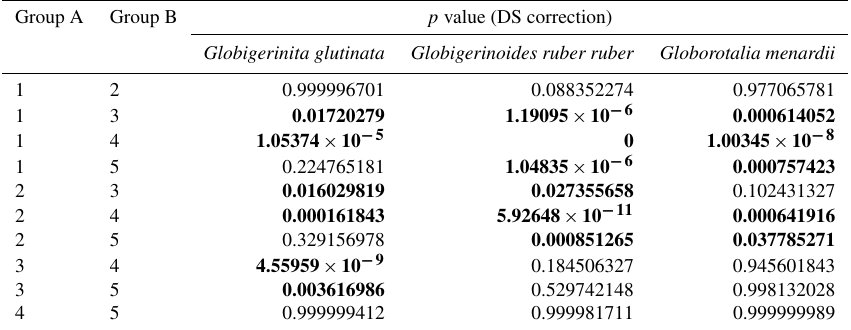
Table A5. Results of the Kruskal–Wallis tests with Dunn–Šidák correction (DS) for the three species of studied planktonic foraminifera, with the comparison groups A and B for the depth comparison (1 represents surface, 2 represents supra-epipelagic, 3 represents epipelagic, 4 represents infra-epipelagic, and 5 represents mesopelagic, as defined in Sect. 2.3 and in Table A2). Statistically significant results are highlighted with bold